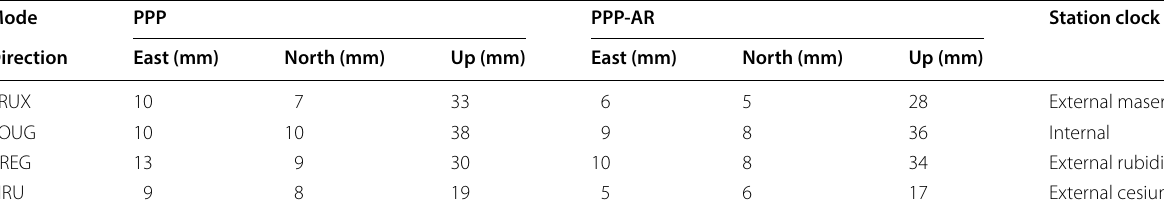
External cesium